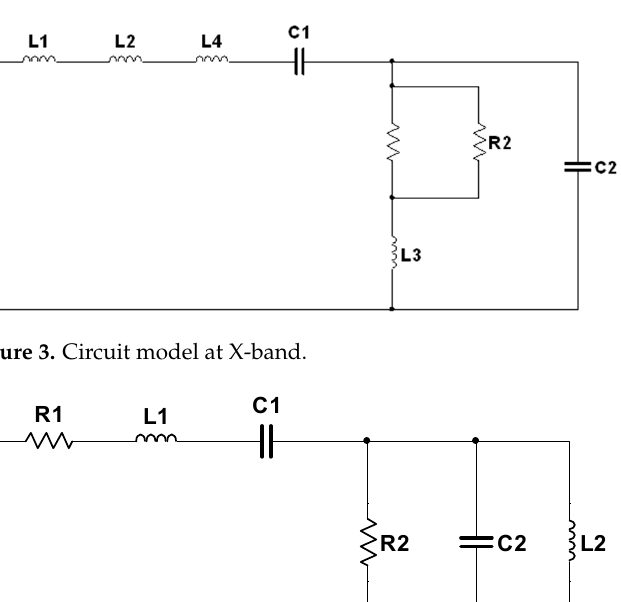
Table 3. Component values of the lumped-element circuit (Figure 4) for scaffold composites of Wangi rice starch and nHA at Ku-band. Composition